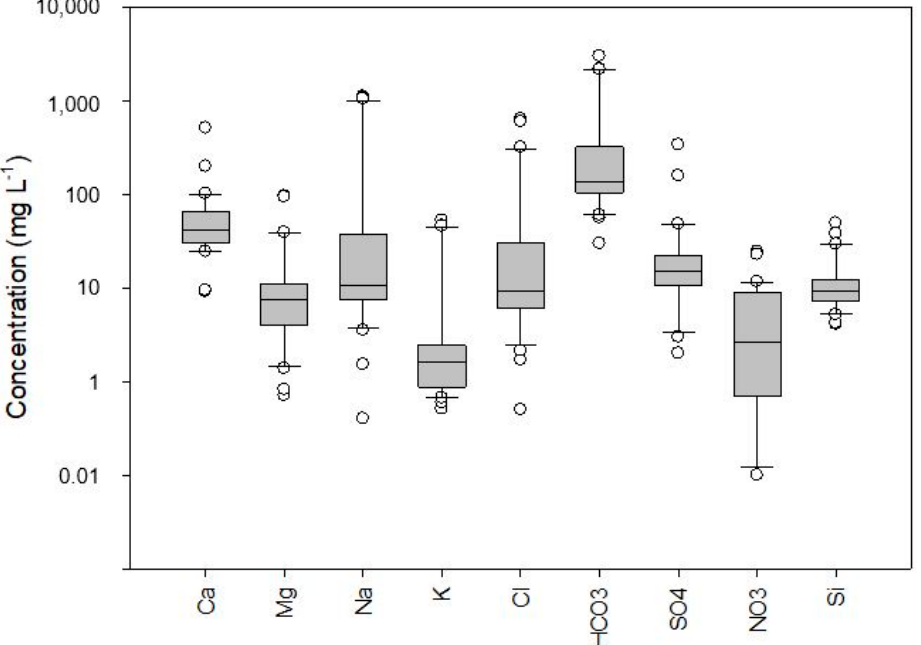
Figure 3. Box plots for major ions in the sampled mineral waters ( n = 29 samples). Boxes correspond to the inter-quartile range of the distribution; whiskers correspond to no more than 1.5 times the inter-quartile range and outliers are shown as black open circles.